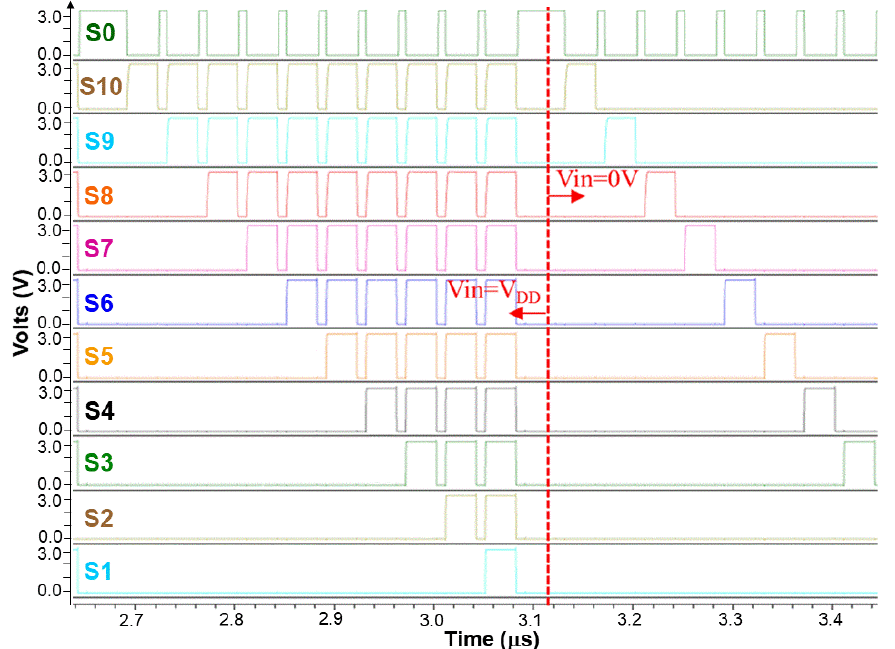
Figure 8. Signal generation circuit of DAC switch S n .